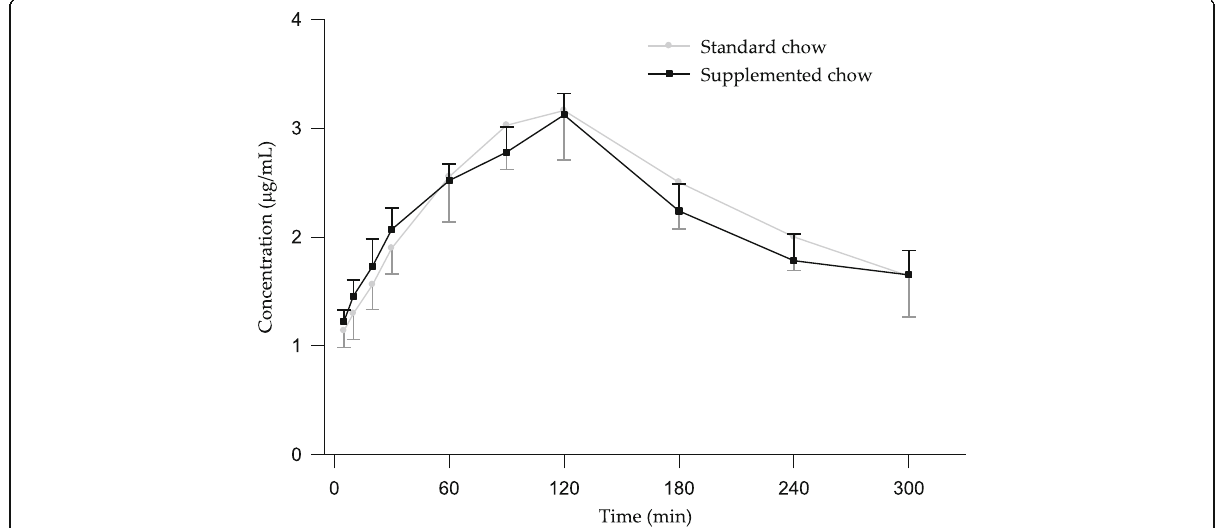
Fig. 3 Mean plasma concentrations of metformin in diabetic rabbits after its oral administration (30 mg/kg) with Plantago ovata husk (300